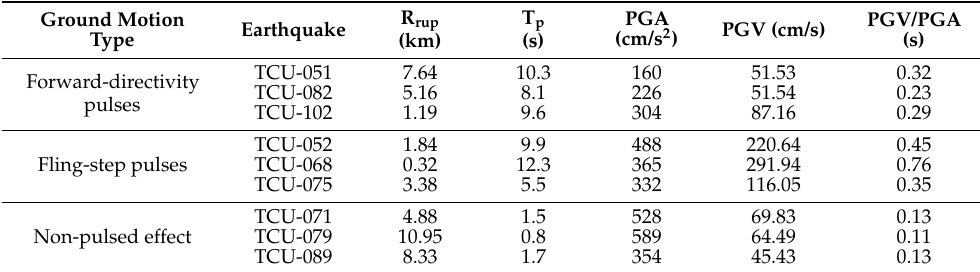
Table 1. Characteristics of different types of ground